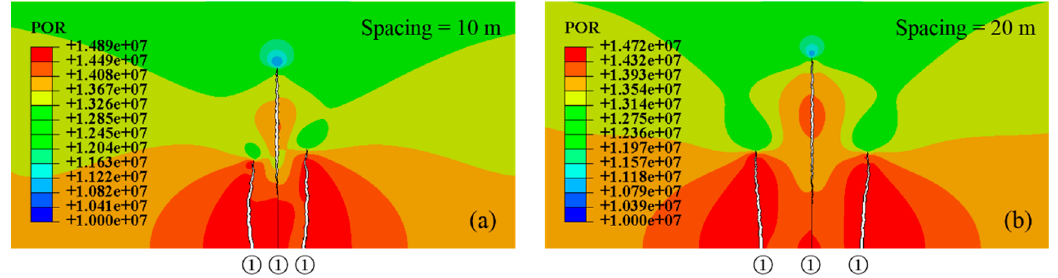
Figure 9. Fracture geometries of simultaneous fracturing with different closely-spacing (POR is the pore pressure: Pa): ( a ) Fracture geometries of spacing = 10 m; ( b ) Fracture geometries of spacing = 20 m.